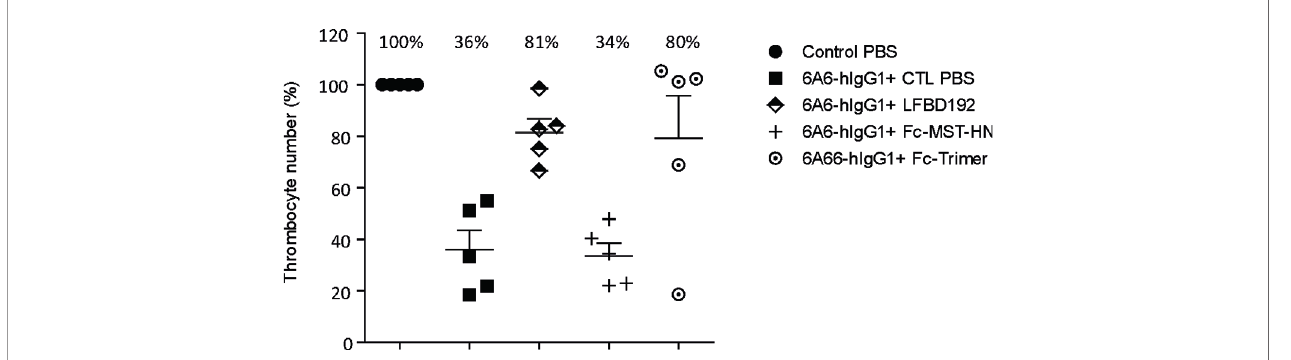
FIGURE 6 | LFBD192 displayed high potency in the prophylactic treatment of ITP in a humanized FcRn mouse model. Platelet numbers 24 h after intraperitoneal injection of anti-platelet 6A6-hIgG1 antibody and treatment with PBS, LFBD192, FC-MST-HN, and the Fc-trimer at 50 mg/kg 2 h before ITP induction. Data represent mean thrombocyte percentages ± SEM (